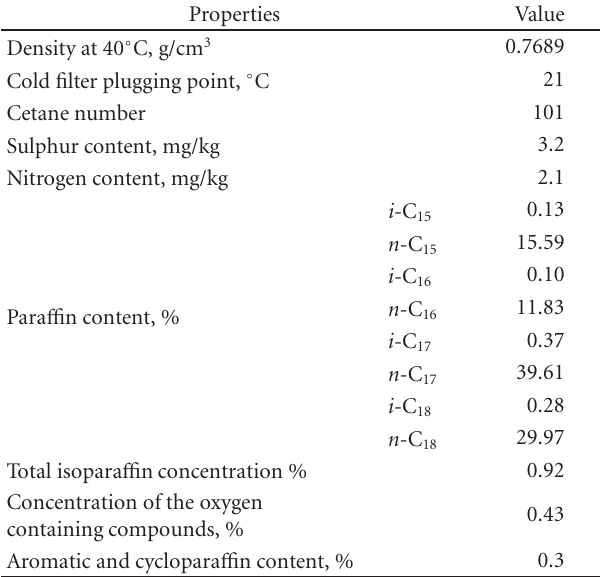
Table 3: Main properties of the high n -para ffi n containing